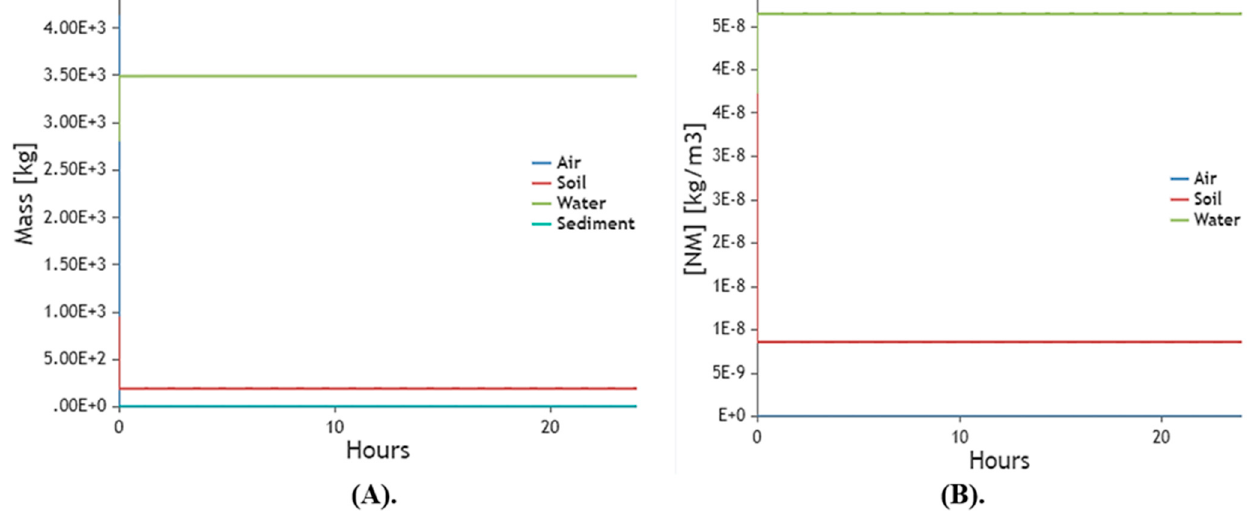
Figure 15. Based on environmental data, this exposure model displays ( A ). ZVI-NPs are being manufactured in large quantities ( B ). ZVI-NPs’ particle generation (on a small scale) at a specific moment.